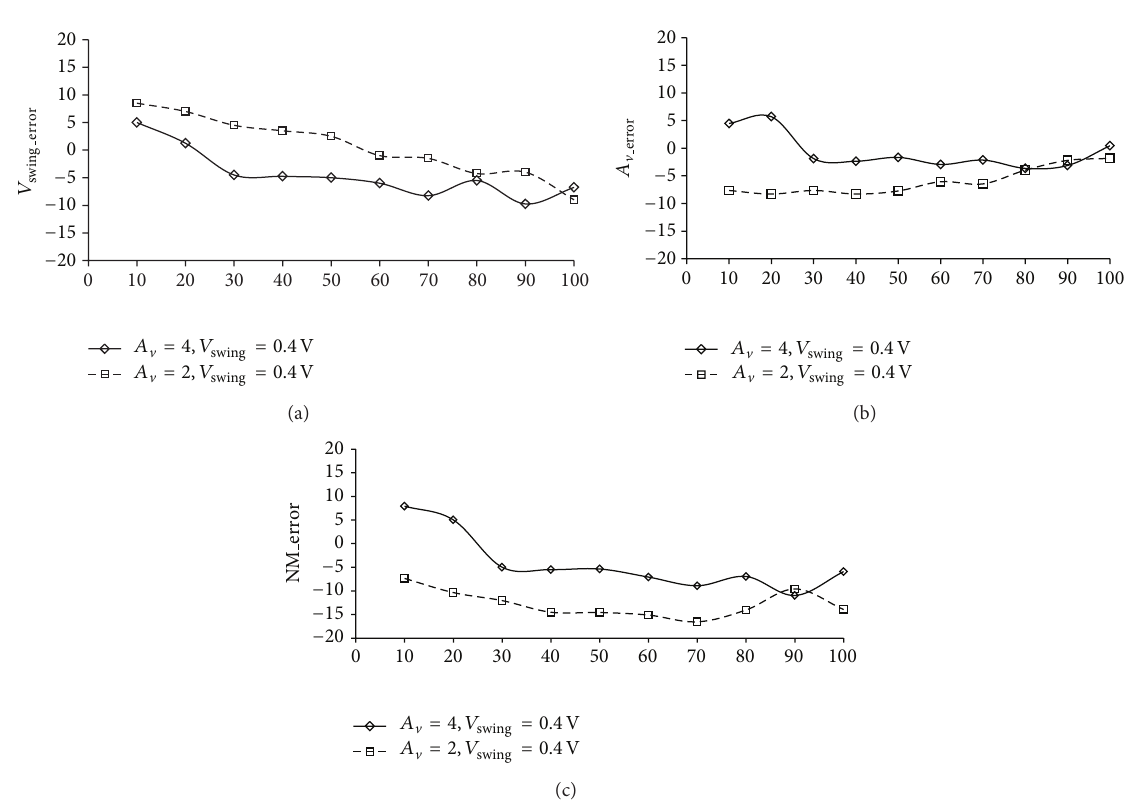
Figure 3: Errors in the static parameters (a) voltage swing, (b) small-signal voltage gain, and (c) noise margin.